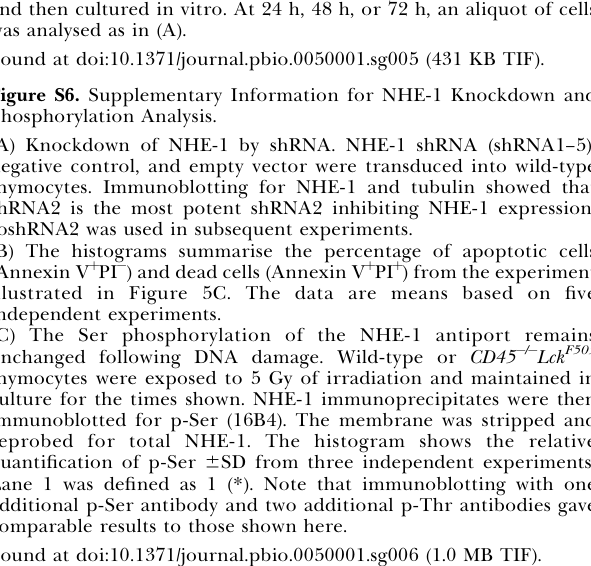
Figure S7. Primary Tumour Cells Are Resistant to DNA Damage– Induced Bcl-x L Deamidation and Apoptosis, but Enforced Alkalinisa- tion Overcomes this